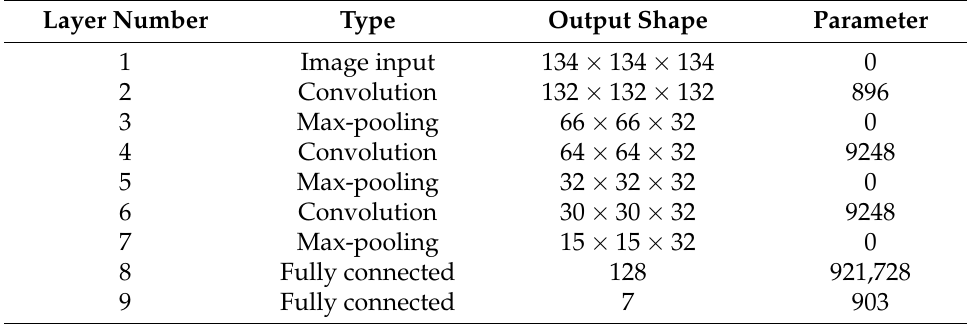
Table 4. Proposed small CNN